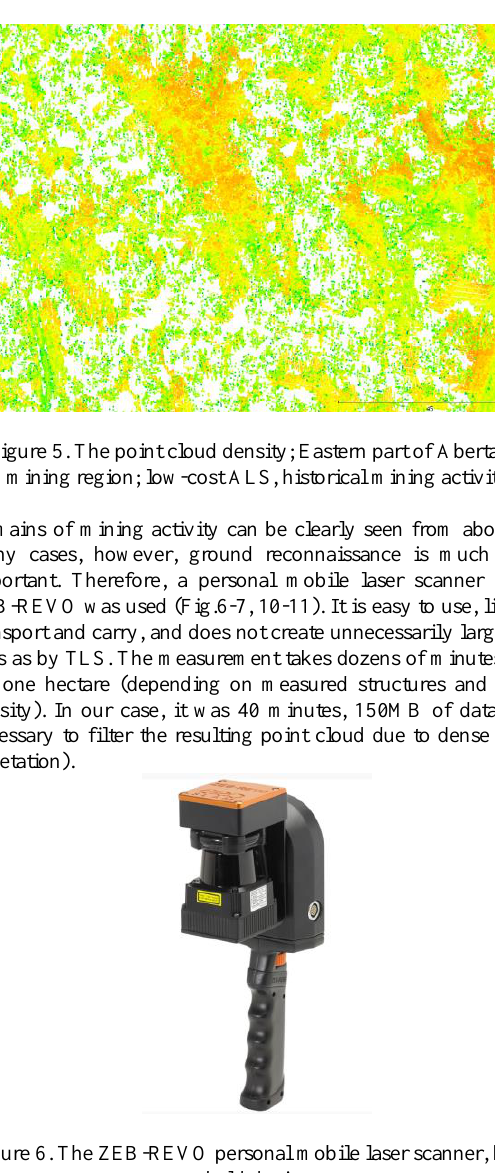
Figure 4. The DRM of Eastern part of Abertamy mining region;